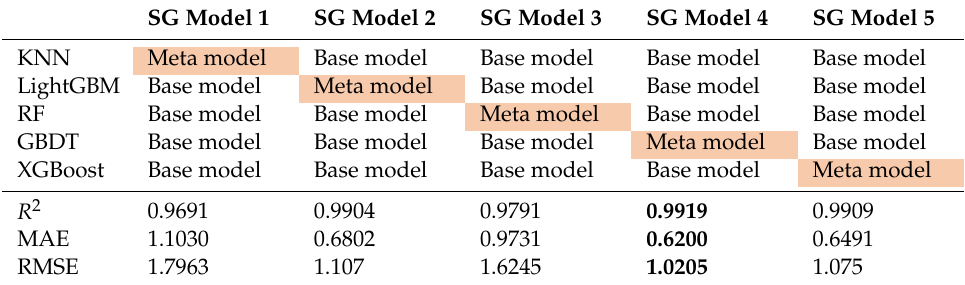
Table 7. Comparison of the SG